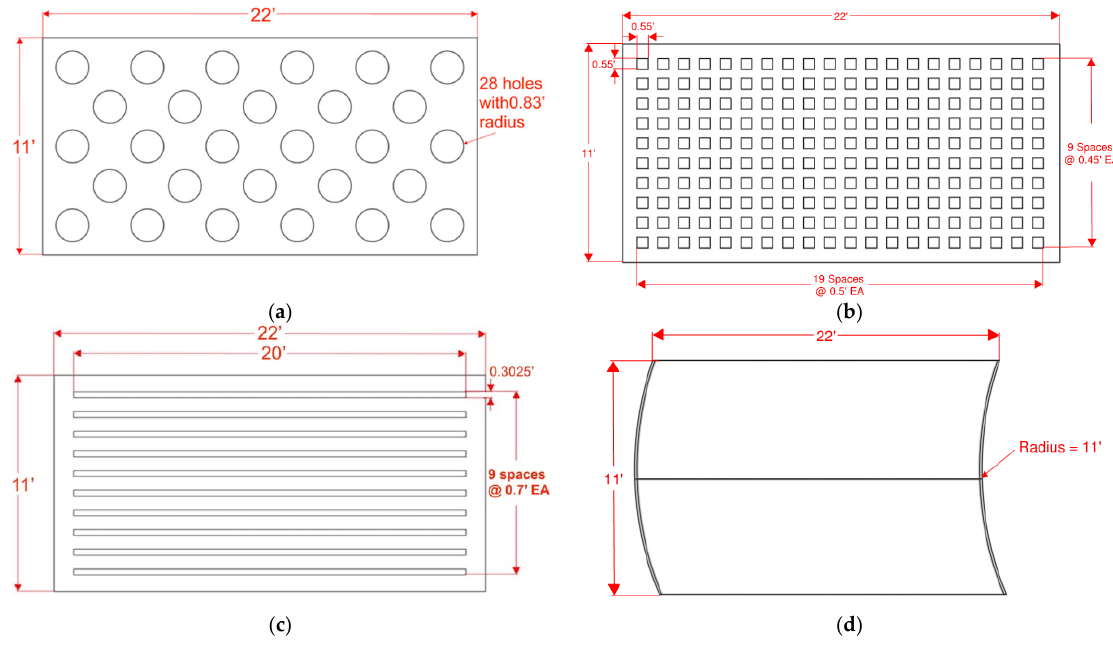
Figure 2. Panel with different geometric configurations in a porosity value of 25%: ( a ) 28 staggered holes, ( b ) 200 uniform square holes, ( c ) 10 rectangular slots, and ( d ) curved (solid)